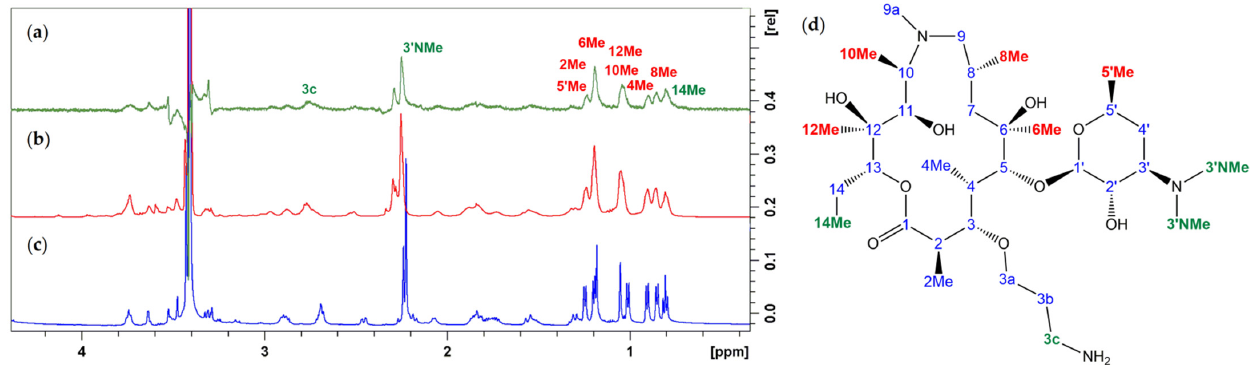
Figure 5. ( a ) STD difference spectrum for 1b after ribosome addition; ( b ) STD off-resonance spectrum after ribosome addition; ( c ) proton spectrum prior to ribosome addition; ( d ) chemical structure, atom numbering and binding epitopes (green and red) of 1b.